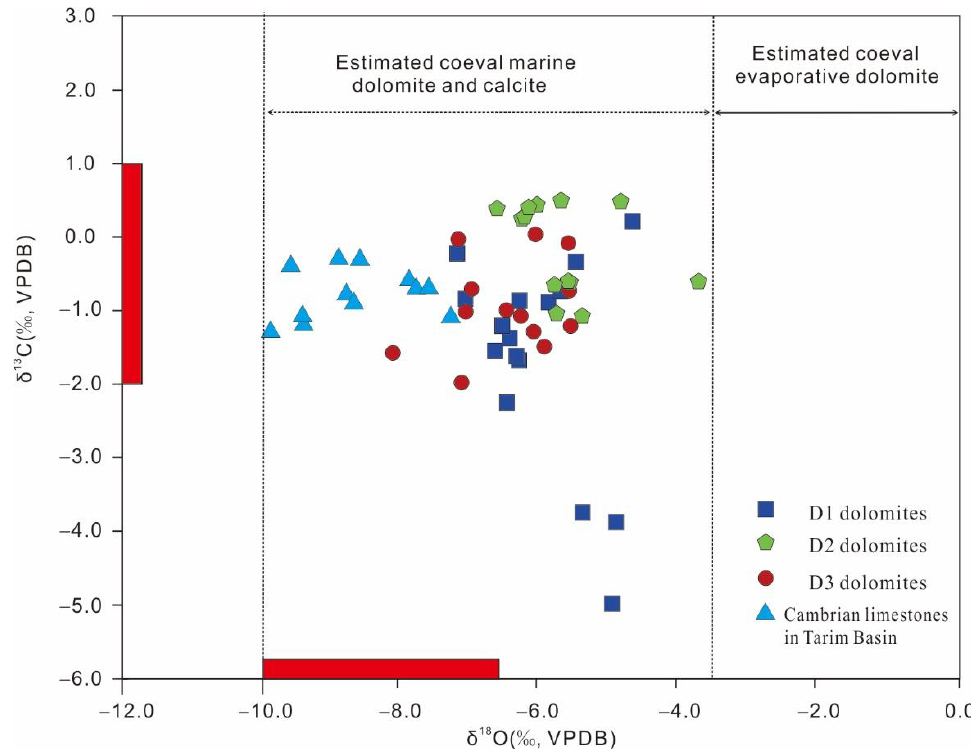
Figure 8. Cross-plot of δ 18 O versus δ 13 C values for D1, D2, and D3 dolomites in the Cambrian successions, Bachu area, Tarim Basin. The δ 18 O and δ 13 C values of Cambrian calcite are derived from Ngia et al. (2019) [31]. The isotope ranges of Cambrian marine calcite (red bars) and the δ 18 O range of coeval evaporative dolomites (solid double arrow) are present for comparison [45,46,48]. The estimated coe val marine dolomite and calcite are calculated using the δ 18 O dolomite − δ 18 O calcite of +3‰VPDB (dashed double arrow) [18,47]. Table 2. Isotopic data (δ 13 C, δ 18 O, and 87 Sr/ 86 Sr) of D1, D2, and D3 dolomites in the Bachu area, Tarim Basin.